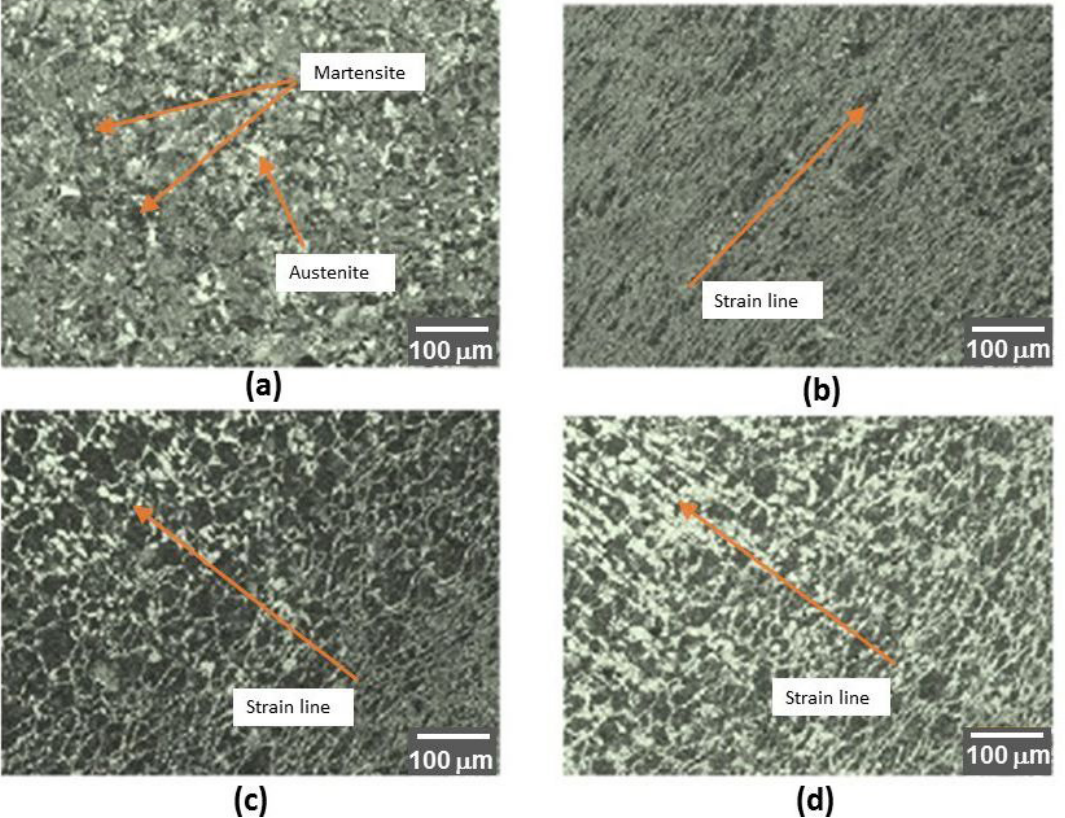
Figure 9. Medium carbon steel at 740 o C, 100X (a) Alone quenched (b) Strain rate 0.1 s -1 , (c) 0.01 s -1 and (d) 0.001 s -1